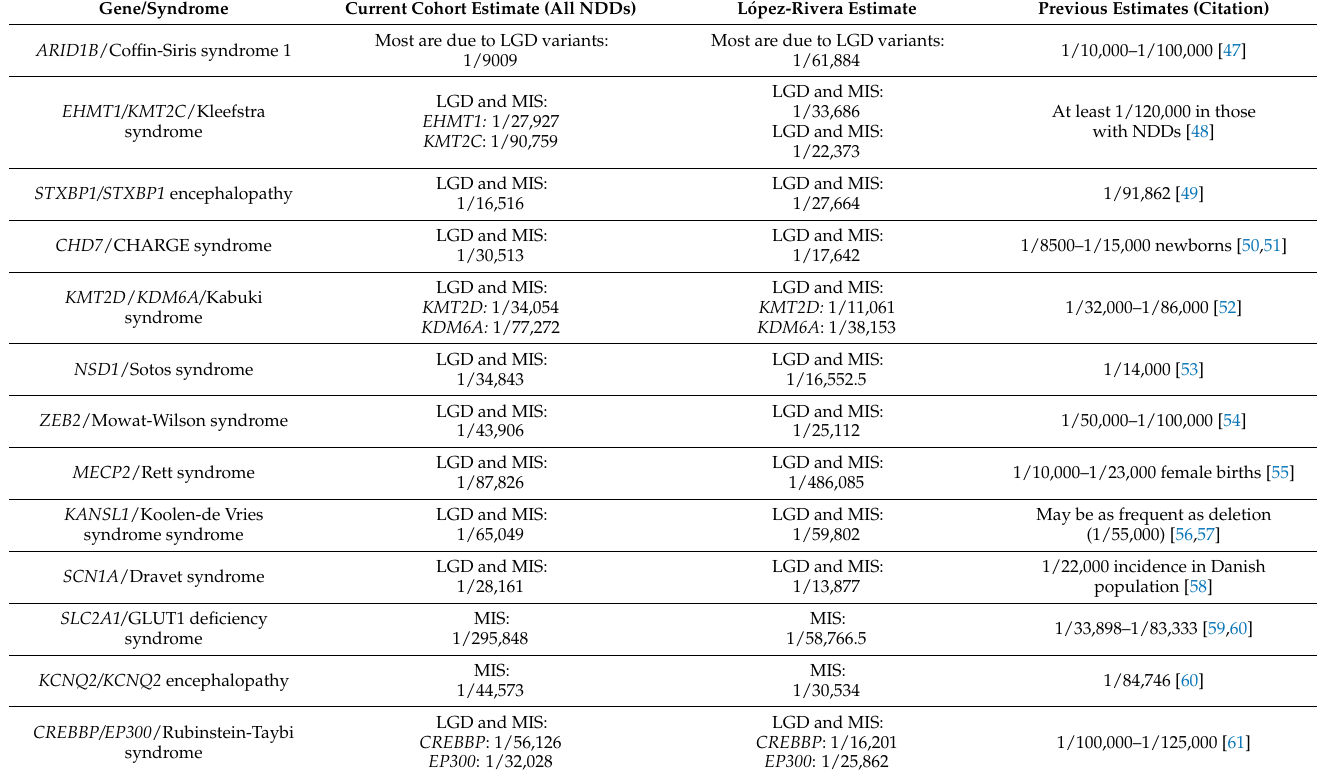
Table 3. Comparison of our prevalence estimates to previous